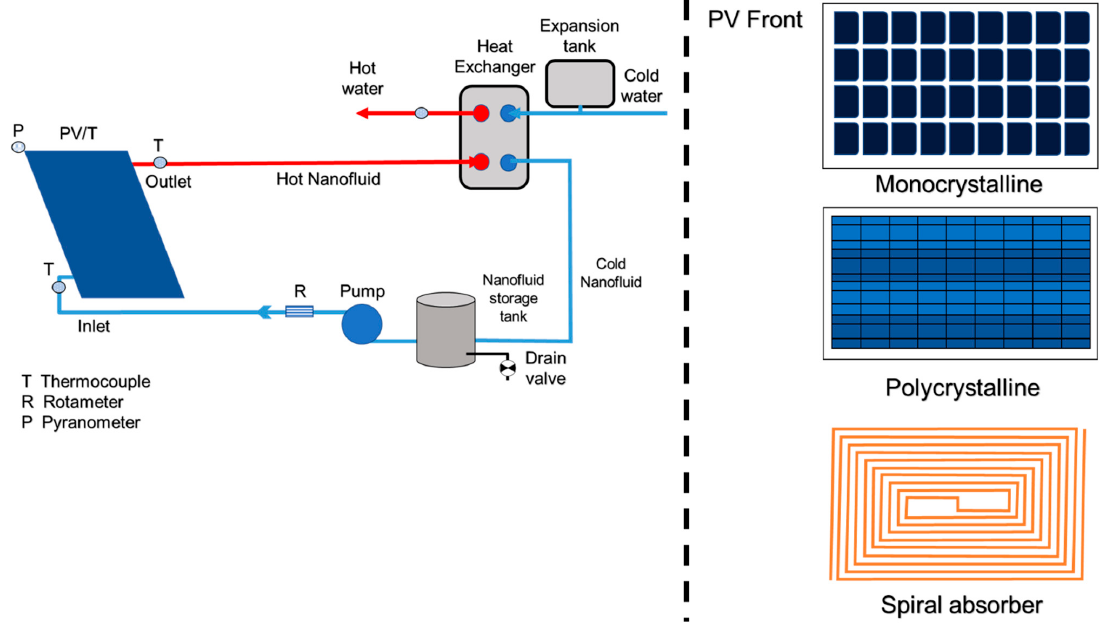
Figure 1. Schematic drawing of the PV/T system used in tests with a spiral heat exchanger. Table 1. The poly and monocrystalline modules